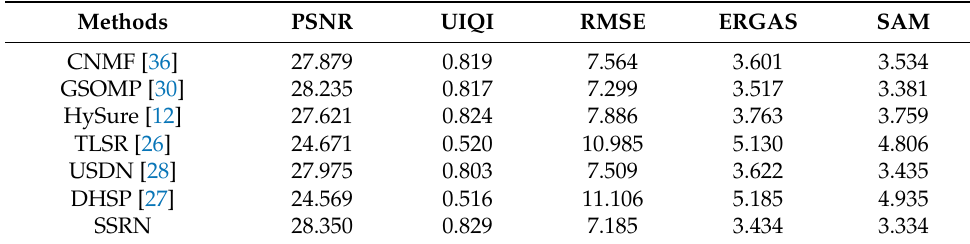
Table 7. Quantitative experimental results on the Paris